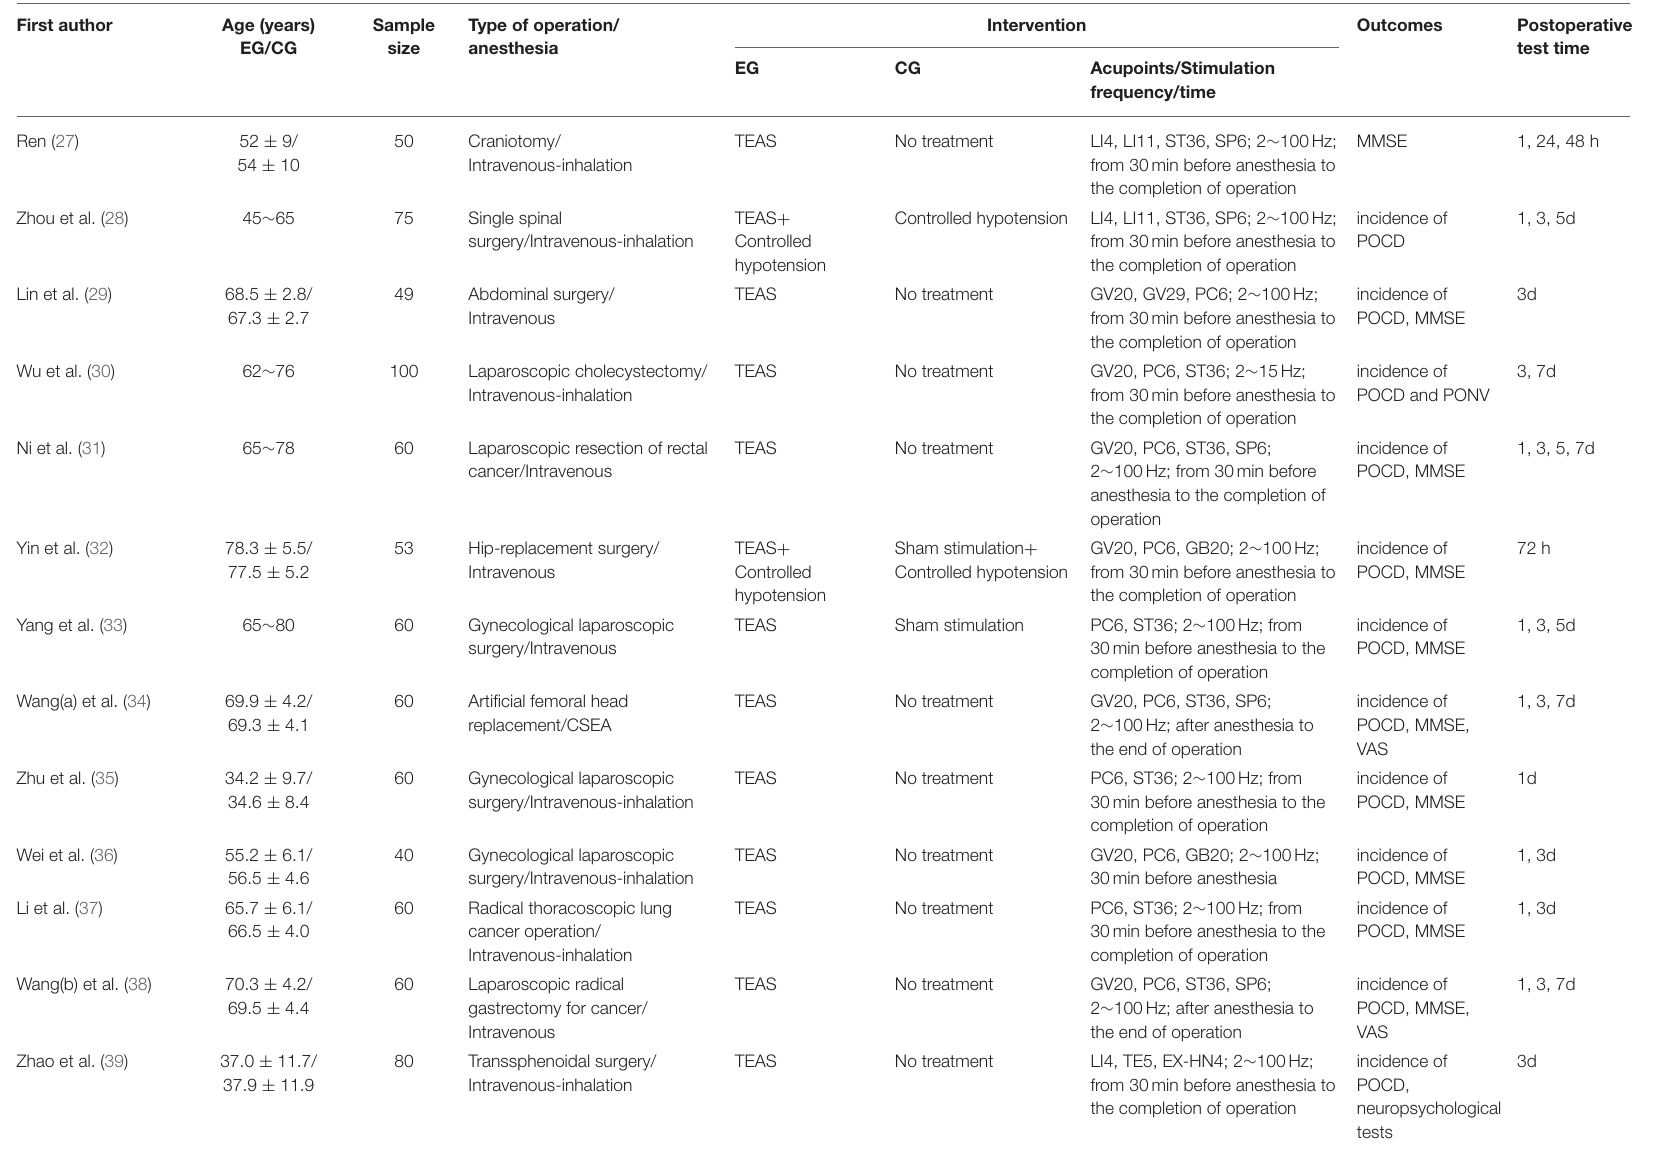
TABLE 1 | Characteristics of the included randomized clinical